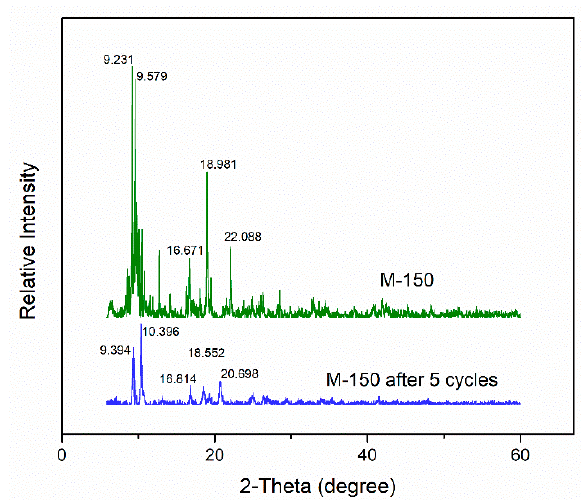
Figure 11. XRD patterns of M-150 before and after the recycling experiments.